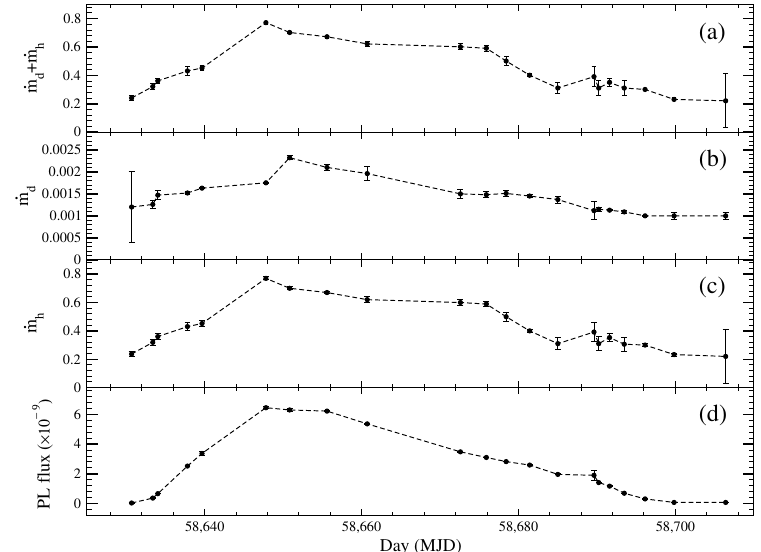
Figure 7. Variation of TCAF model-fitted ( a ) total accretion rate ( ˙ m d + ˙ m h ), ( b ) disk rate ( ˙ m d ) and ( c ) halo rate ( ˙ m h ). The accretion rates are in units of Eddington rate ( ˙ M Edd ); ( d ) 2–10 keV powerlaw flux (obtained from powerlaw model) in photons cm − 2 s − 1 .